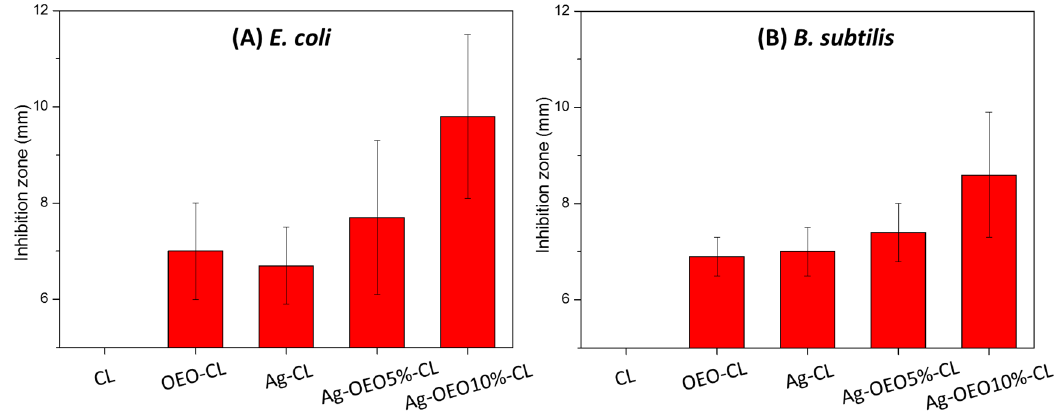
Figure 7. Diameter of inhibition zone with standard deviation of CL, OEO-CL, Ag-CL, Ag-OEO5%-CL, and Ag-OEO10%-CL against ( A ) E. coli and ( B ) B. subtilis.